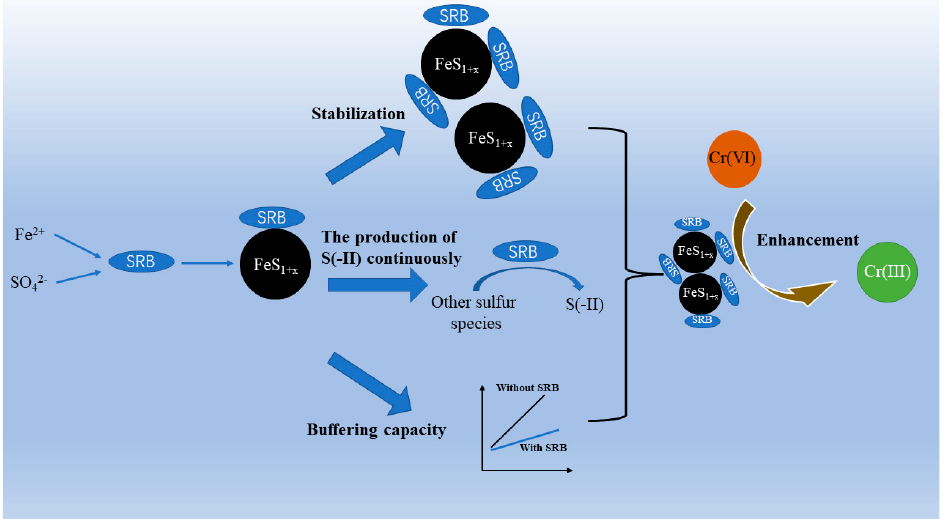
Figure 9. Conceptualized illustration of the mechanisms of the effect of SRB on the removal of Cr(VI) under anoxic conditions. Table 4. Maximum adsorption capacities of some adsorbents for the removal of Cr(VI) ions. Sample